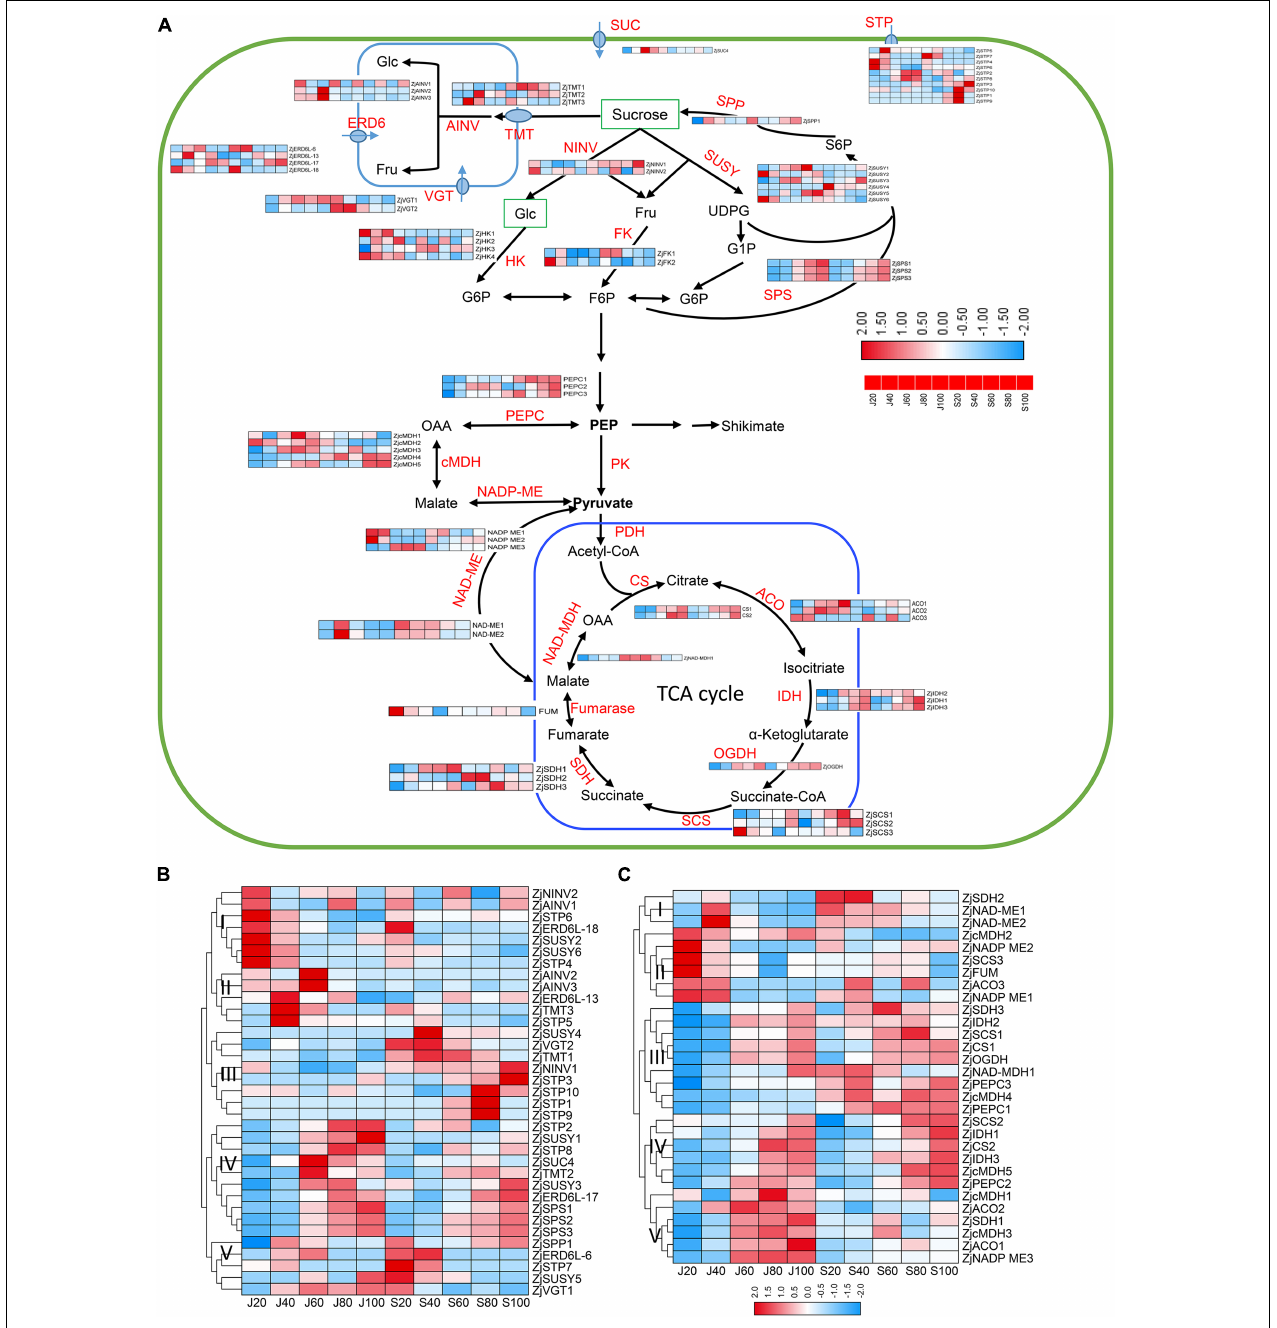
FIGURE 6 | Expression profile of proteins involved in sugar and organic acid metabolism. (A) Pathway of sugar metabolism and transport in jujube fruit. (B) Expression profile of proteins related to sugar metabolism and transport in the fruits of ‘Junzao’ and ‘Qingjiansuanzao’ from 20 DAF to 100 DAF. (C) Expression profile of proteins involved in organic acid metabolism related to glycolysis and TCA cycle in the fruits of ‘Junzao’ and ‘Qingjiansuanzao’ from 20 DAF to 100 DAF . Note that only a subset of primary proteins required for soluble sugar and starch metabolism and transportation in jujube fruits is displayed. The heatmaps were drawn using log 2 -transformed protein abundance. Abbreviations of enzymes for sugar metabolism and transportation: FK, fructokinase; F6P, fructose-6-phosphate; Fru, D-fructose; Glc, D-glucose; G6P, glucose-6-phosphate; NINV, neutral invertase; SPP, sucrose-phosphate phosphatase; SPS, sucrose-phosphate synthase; SUC, sucrose carrier or transporter; SUSY, sucrose synthase; UDPG, UDP-D-glucose; AINV, vacuolar acid invertase; VGT, vacuole glucose transporter; ERD6, ERD6-like transporters. STP, Sugar Transport Protein; SUC, Sucrose transporter; TMT, tonoplast membrane transporter. Abbreviations of enzymes for TCA cycle and cytoplasmic malate metabolism: PK, pyruvate kinase; PDC, pyruvate dehydrogenase complex; PDH, pyruvate dehydrogenase; CS, citrate synthase; IDH, isocitrate dehydrogenase; OGDH, 2-oxoglutarate dehydrogenase; SCS, succinyl-CoA synthetase; SDH, succinate dehydrogenase; FUM, Fumarase; cMDH, cytosolic malate dehydrogenase; NAD-ME, NAD-malic enzyme; NADP-ME, NADP-malic enzyme; PEPC, phosphoenolpyruvate carboxylase.